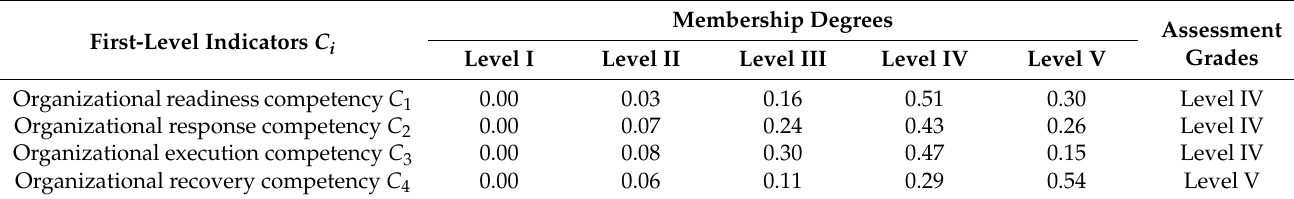
Table A14. Assessment information matrixes of first-level